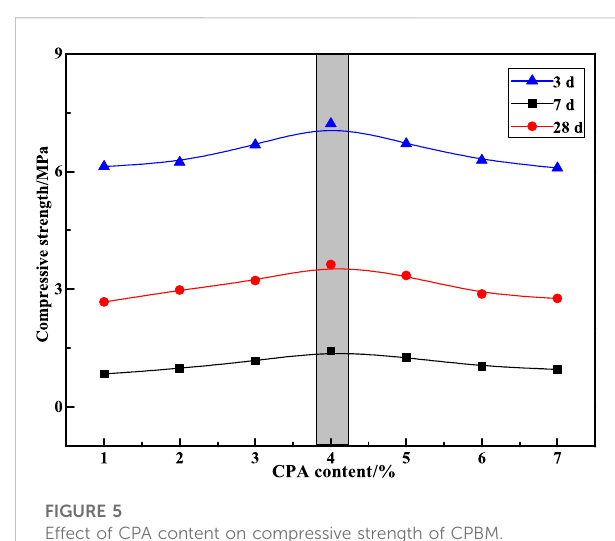
FIGURE 5 Effect of CPA content on compressive strength of CPBM.